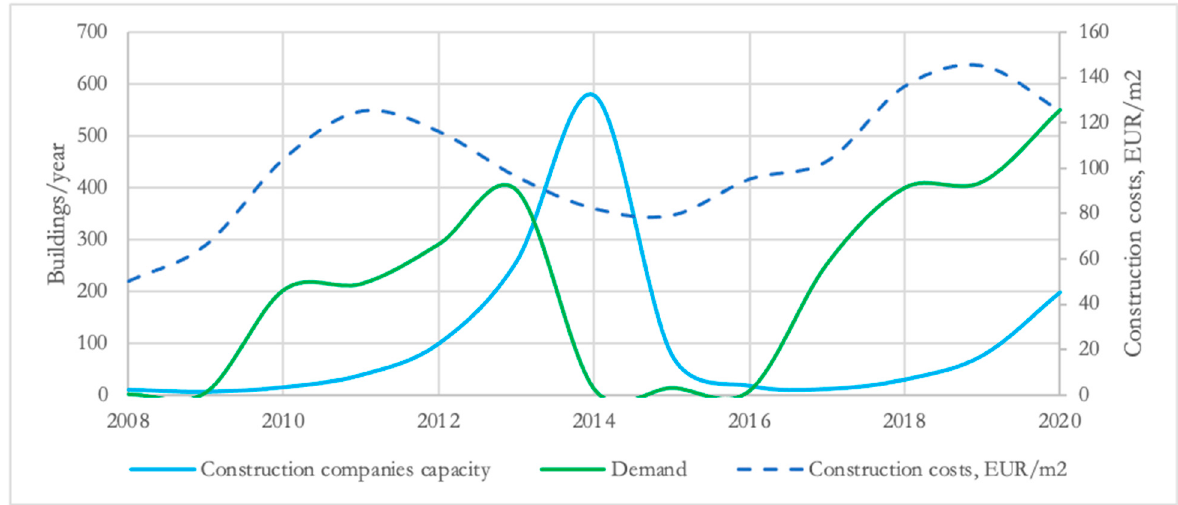
Figure 14. Simulated supply, demand, and prices of construction works for multi-family buildings and the public sector with the existing policy tools in force.